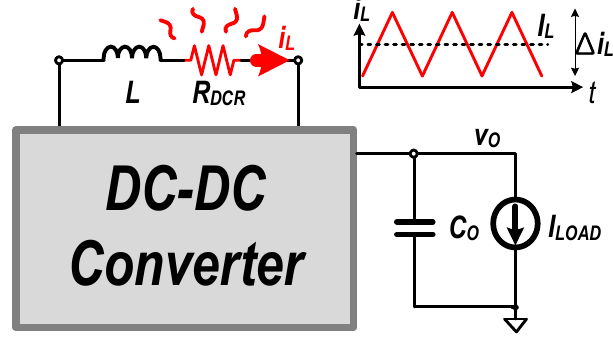
Figure 2. Conduction loss of a parasitic DC resistance ( R DCR ) of the inductor in heavy load conditions.